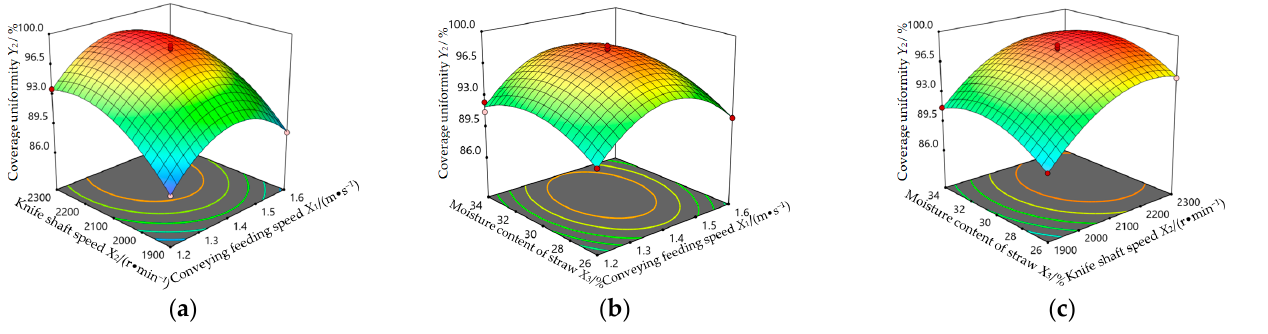
Figure 14. Response surface of interactive factors to coverage uniformity. ( a ) Coverage uniformity response surface under factors X 1 and X 2 ; ( b ) Coverage uniformity response surface under factors X 1 and X 3 ; ( c ) Coverage uniformity response surface under factors X 2 and X 3 .